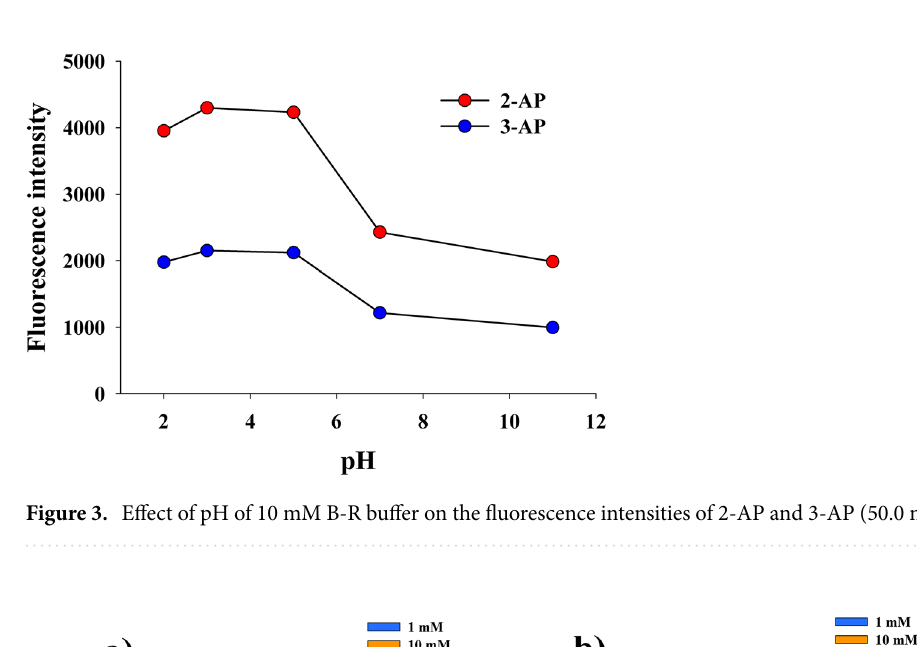
Figure 2. Excitation and emission spectra of 50.0 ng/mL of ( a ) 2-AP in 10 mM phosphate buffer of pH 3.0 and ( b ) 3-AP in 10 mM H 2 SO 4 .